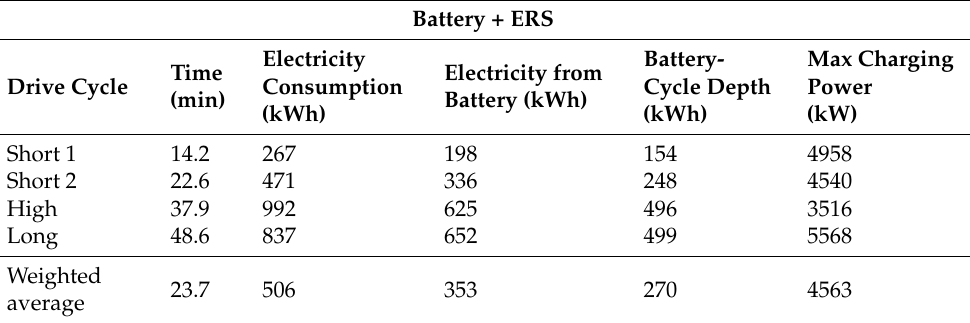
Table 5. Cycle time, electricity consumption and battery usage for the drive cycles under battery operation with